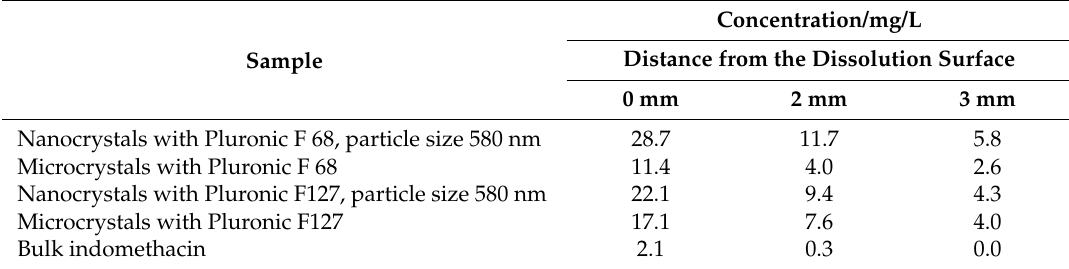
Table 2. Surface concentrations after 10 min of dissolution of indomethacin compressed surfaces (modified from